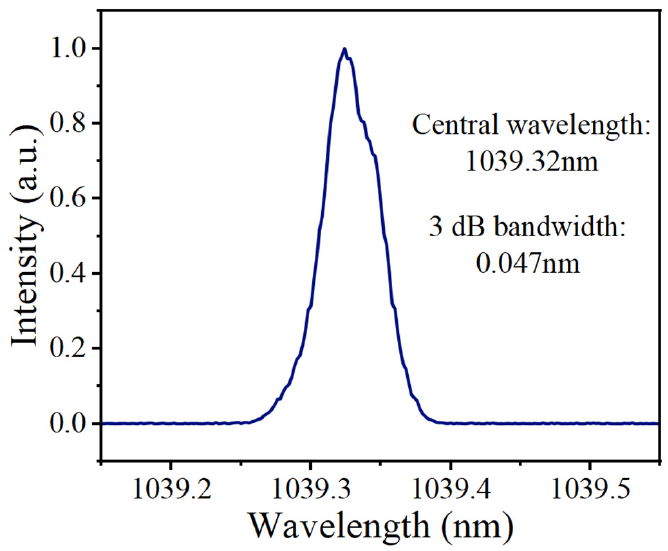
Figure 8. The spectrum at 180 mW pump power.